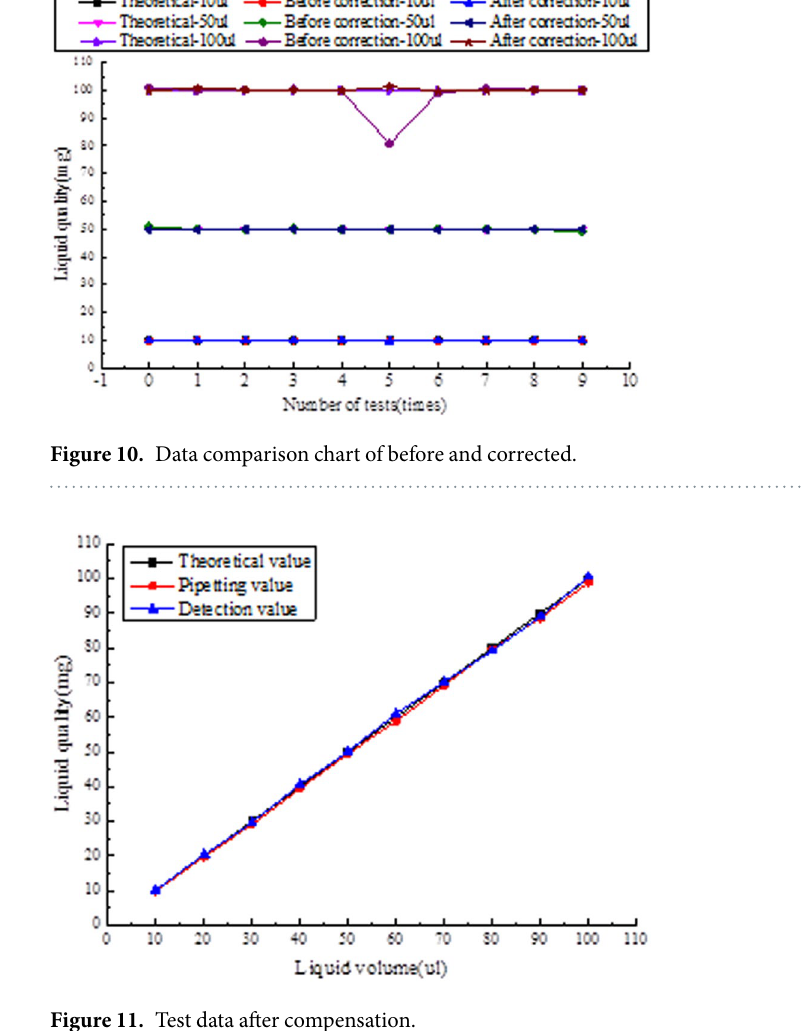
Figure 11. Test data after compensation.